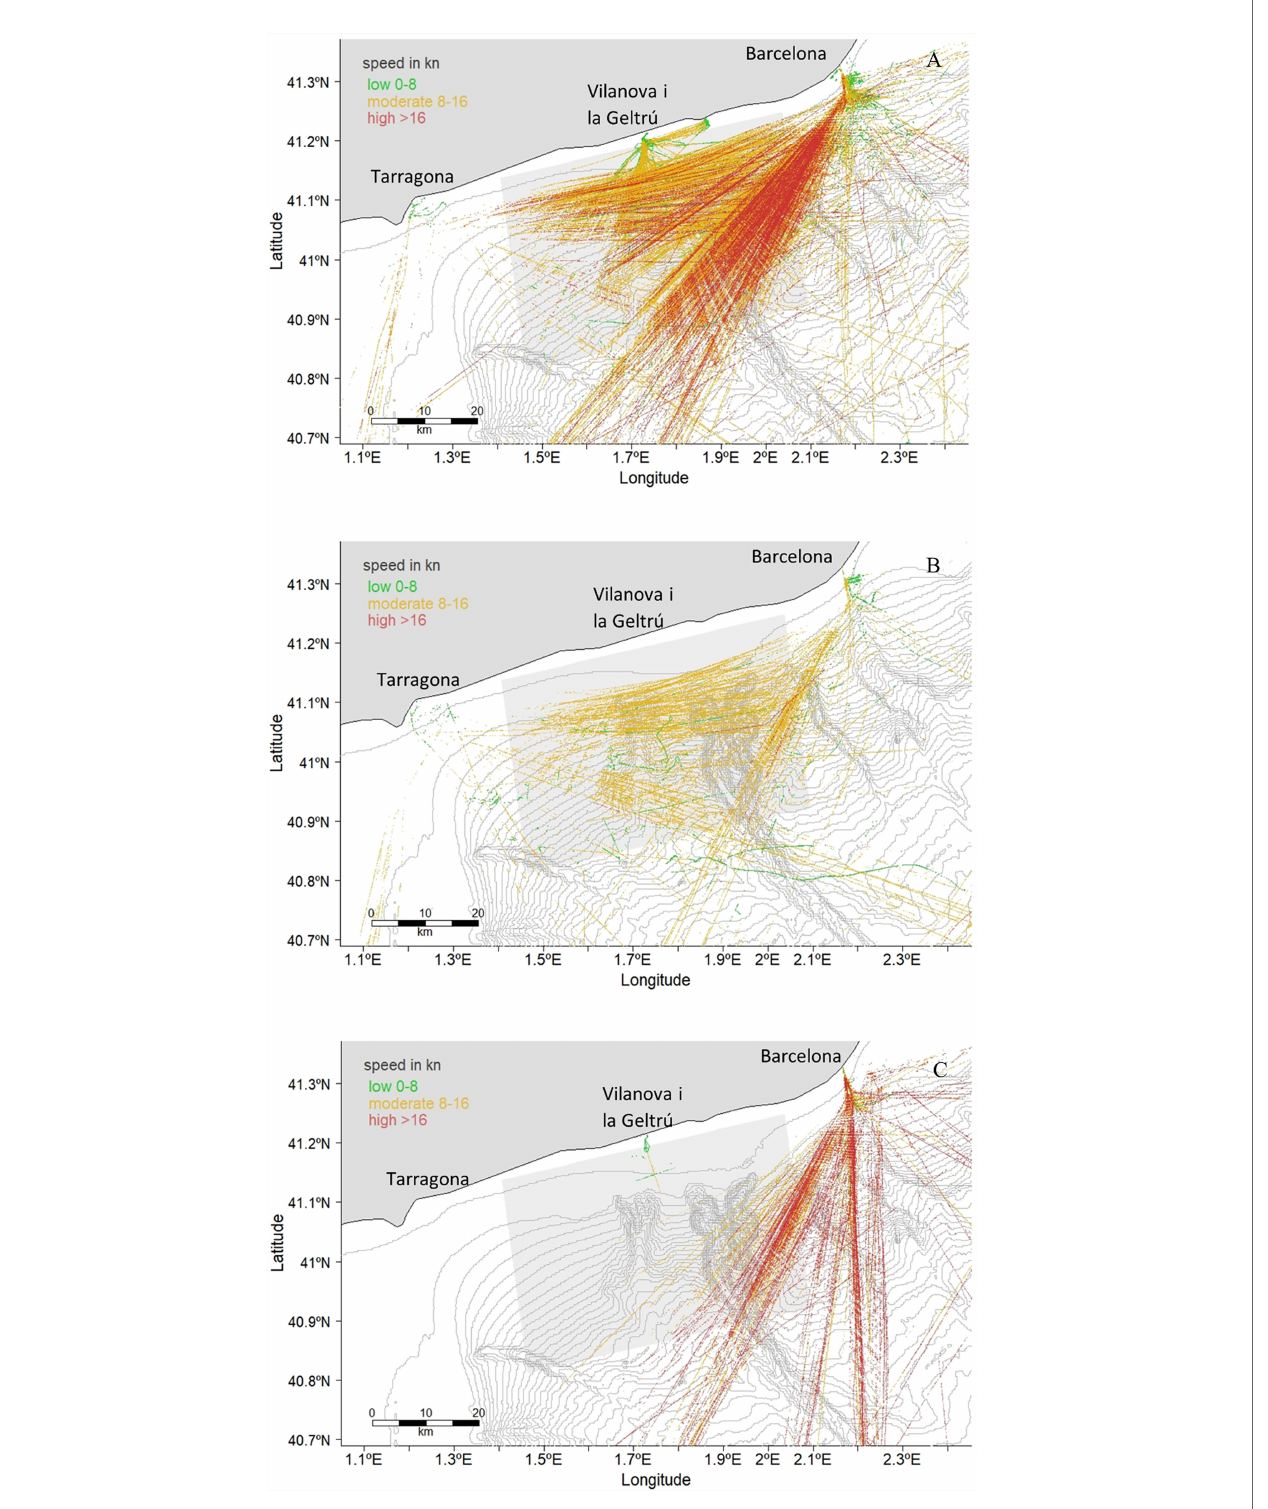
FIGURE 6 | Vessel positions for Cargo (A) , Tanker (B) and Passenger (C) vessels in April from pooled AIS data between 2011 and 2020. The bathymetry is represented by isobaths every 50 m and the study area is